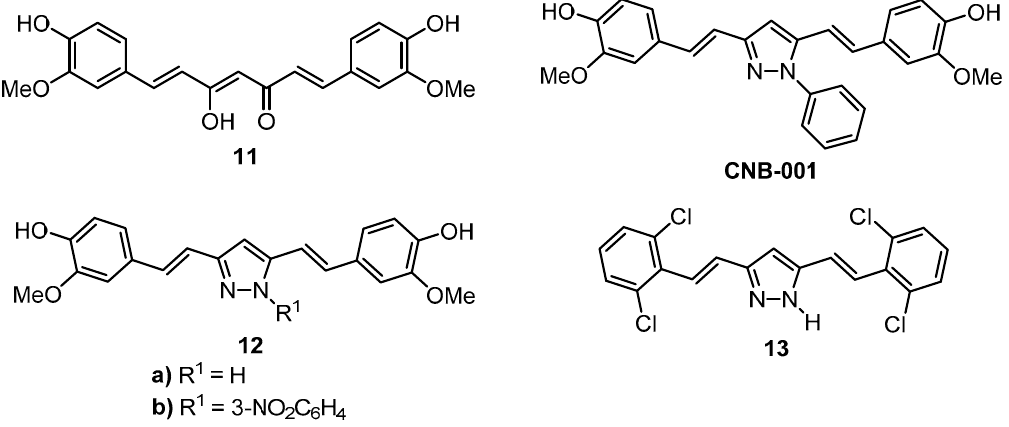
Figure 5. Structures of curcumin ( 11 ) and 3,5-bis(styryl)pyrazoles CNB - 001 , 12 and 13 , presenting antioxidant, antimalarial, cytotoxic and antiproliferative activities [36–44].